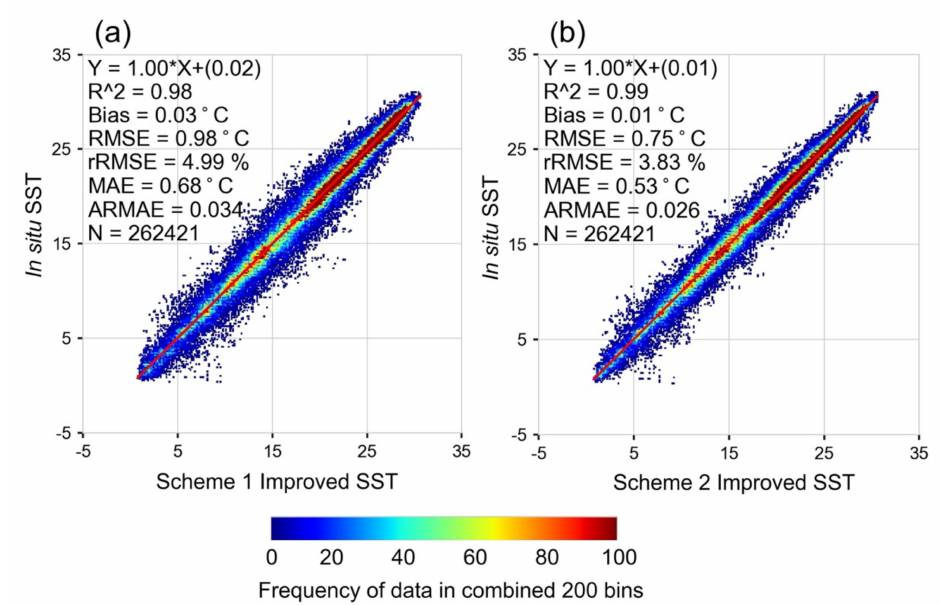
Figure 7. Scatterplots of Leave-One-Year-Out-Cross-Validation (LOYOCV) results for ( a ) scheme 1-improved SST and ( b ) scheme 2-improved SST from 2015 to 2019. The scheme-improved SST was derived through the data fusion of bias corrected satellite